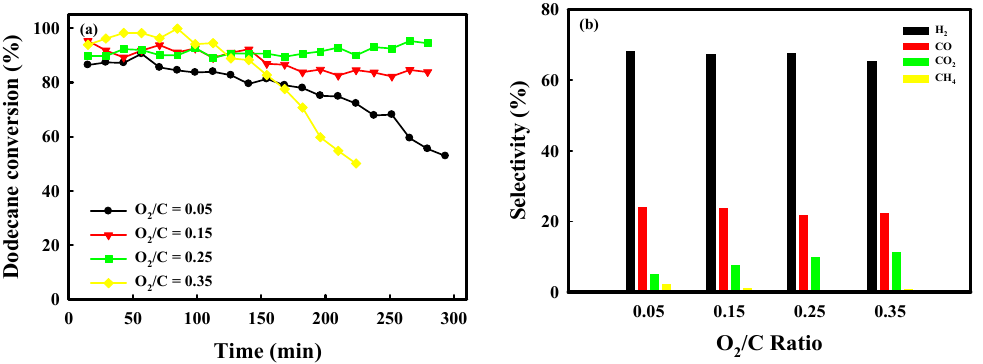
Figure 8. Effect of O 2 /C ratio on catalytic performance: ( a ) Dodecane conversion and ( b ) initial selectivity of auto-reduced NA10-PM catalyst under S/C = 1.23, and GHSV = 12,000 h − 1 at 750 °C.